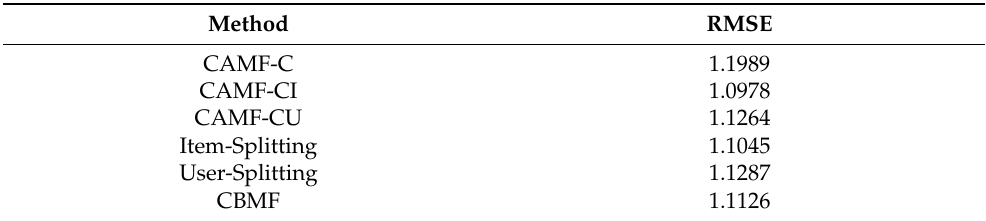
Table 9. Numerical Results of the methods on the Travel-STS dataset.